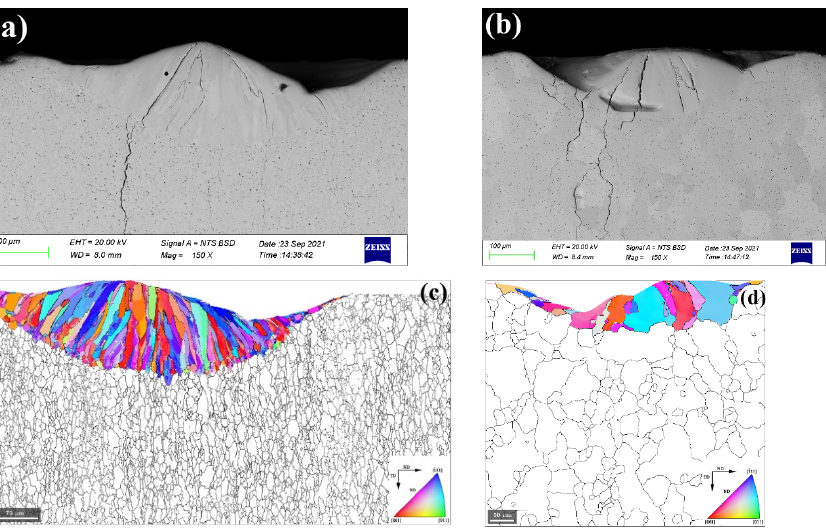
Figure 16. The BSE image (top) and orientation map (bottom) of the TD–ND surface of the rolled samples ( a , c ) and fully recrystallized samples ( b , d ) at 0.64 GW/m2.